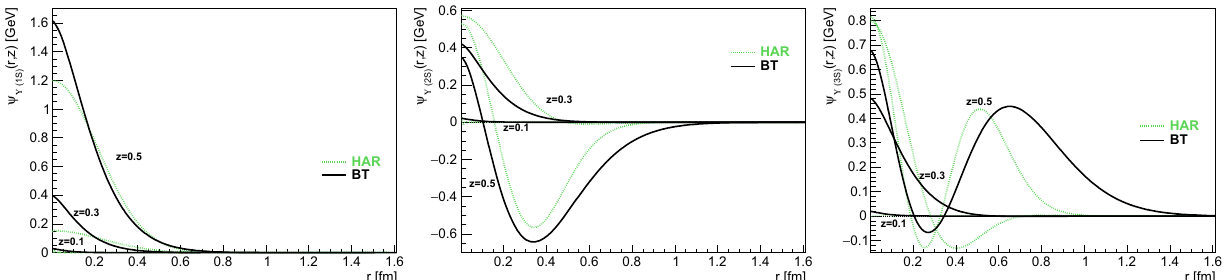
Fig. 4 The LC wave function (cid:5) V ( r , z ) for ϒ( 1 S ) (left panel), ϒ (cid:2) ( 2 S ) (middle panel) and ϒ (cid:2)(cid:2) ( 3 S ) (right panel) mesons for different quark momentum fractions z . The distribution function (cid:5) V ( r , z ) is generated